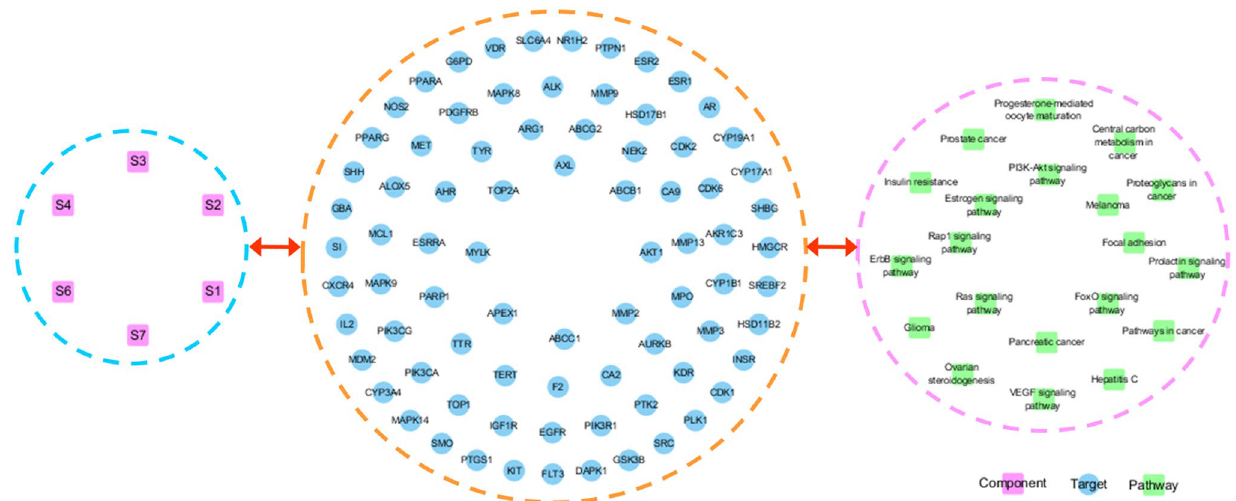
ing pathways identified from KEGG) were shown in pink, blue and green, respectively